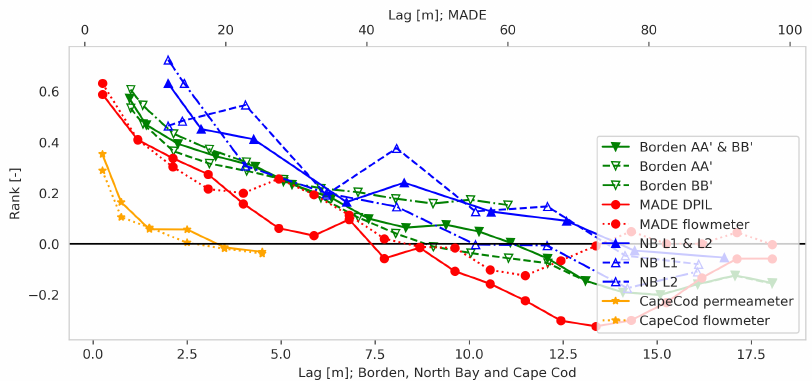
Figure 6. Correlograms versus separation distance for common data-sets in stochastic